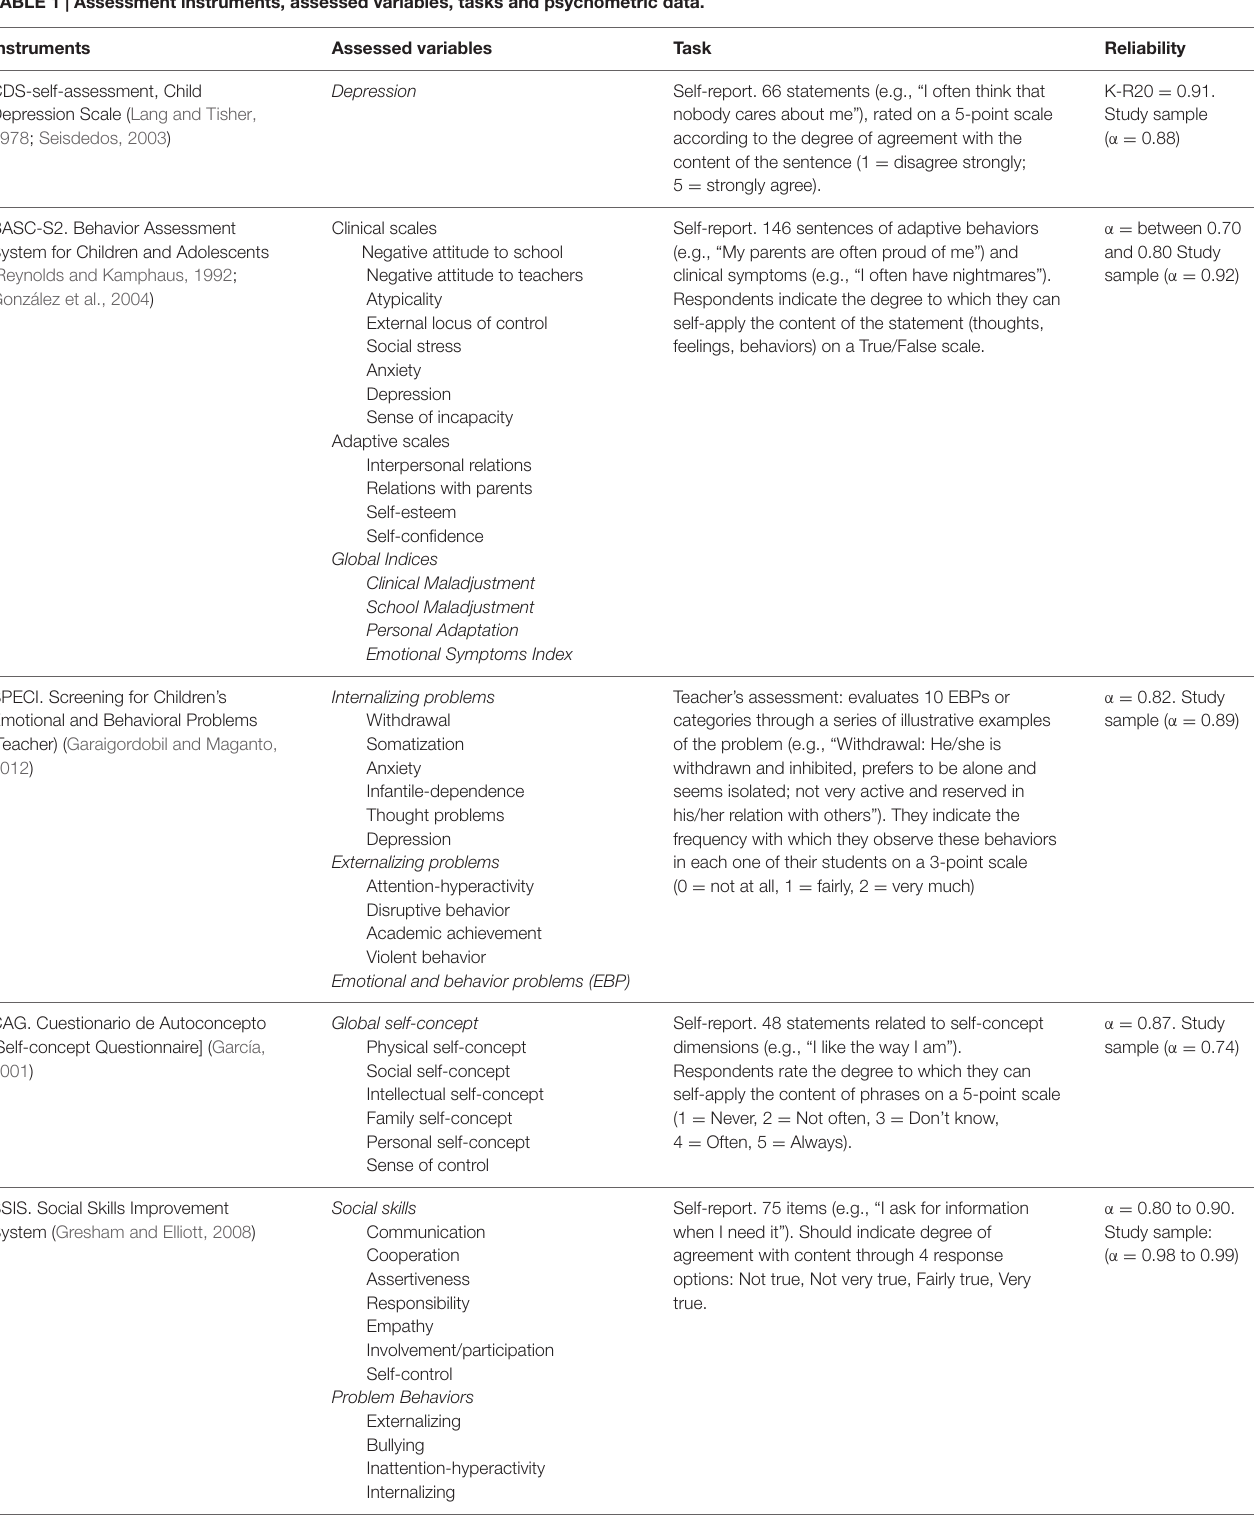
TABLE 1 | Assessment instruments, assessed variables, tasks and psychometric data.